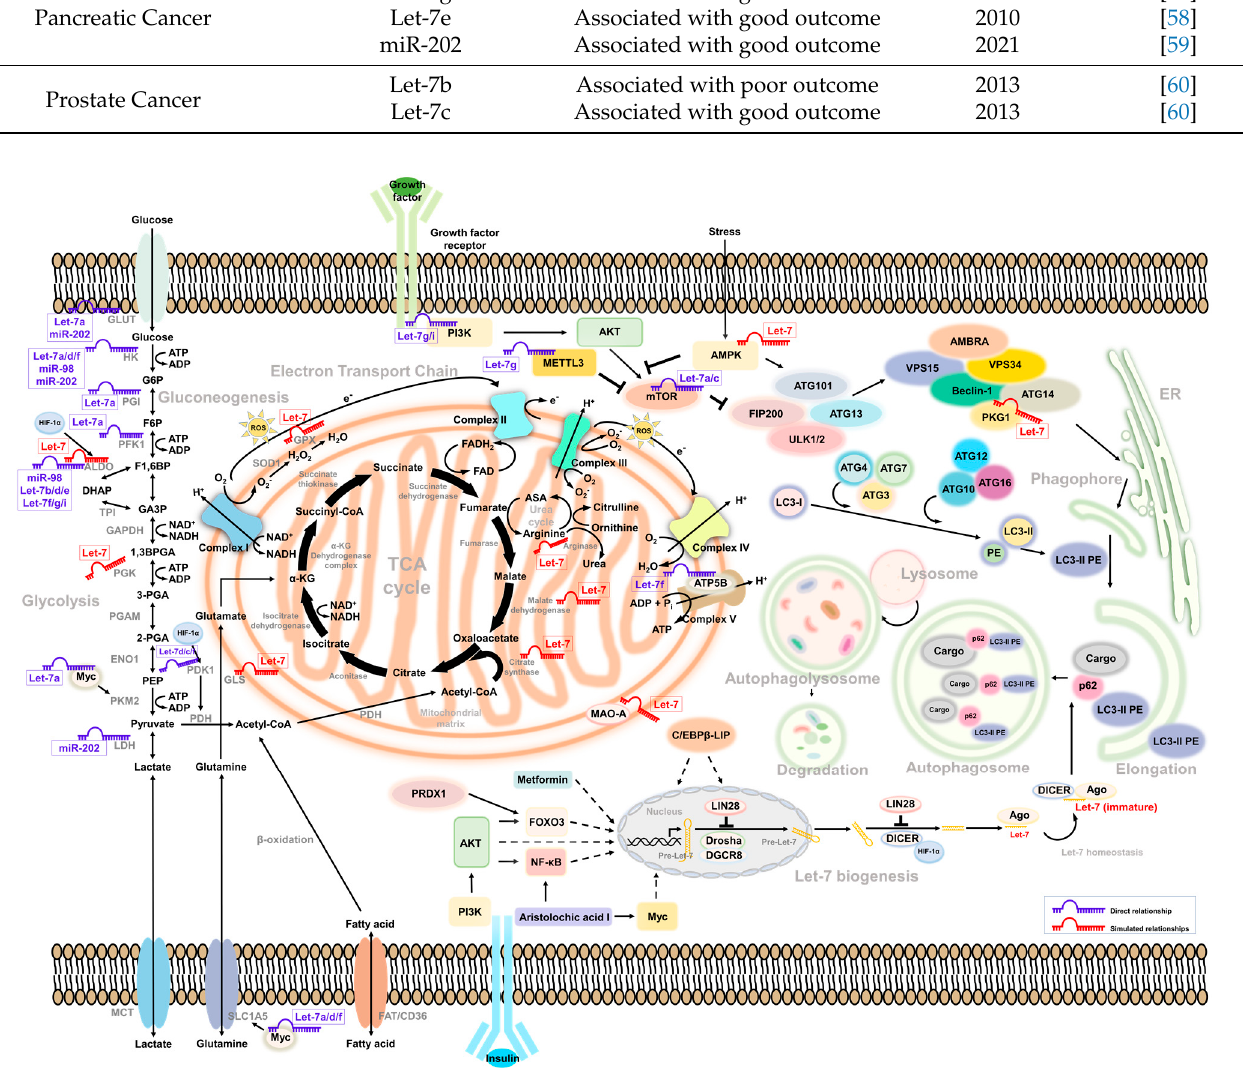
Figure 1. Intermediate mediators/molecules between Let-7-associated glucose metabolism and autophagy.